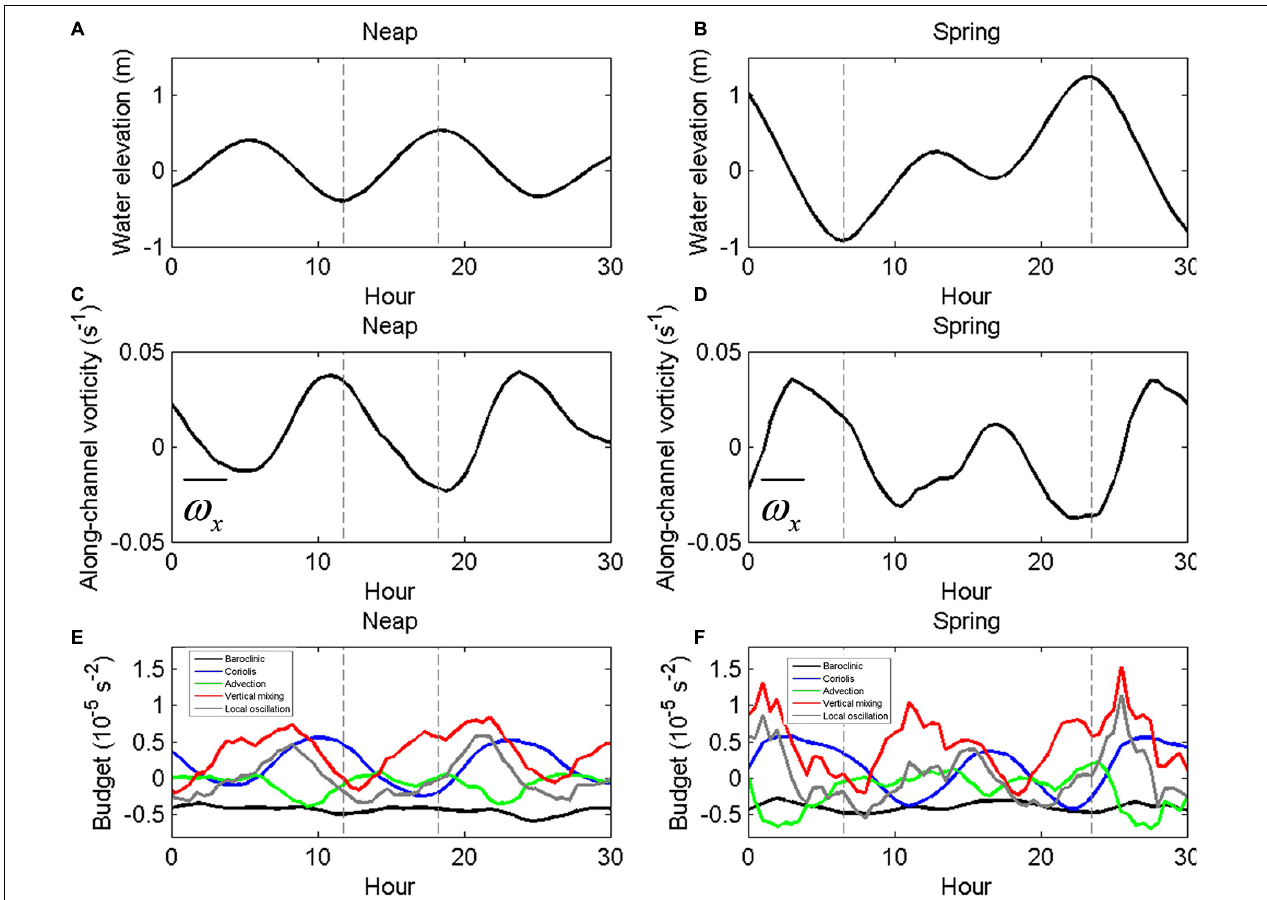
FIGURE 9 | Time variations of water elevation, cross-section averaged along-channel vorticity, and vorticity budget during neap tide (A,C,E) and spring tide (B,D,F) at the cross-channel section S. The gray dashed lines represent times of maximal ebb and